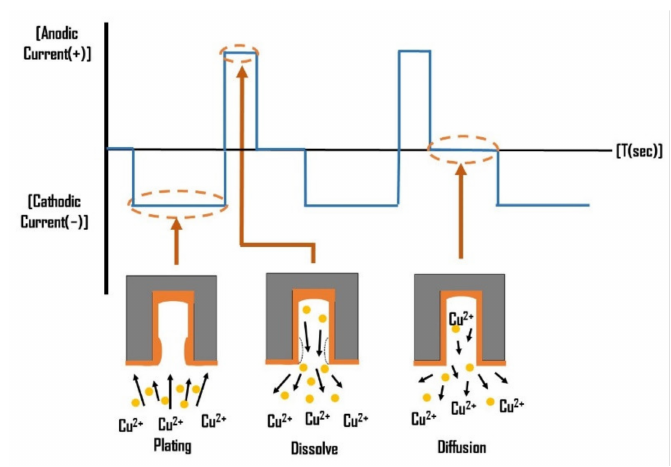
Figure 11. Plating characteristics of periodic pulse reverse